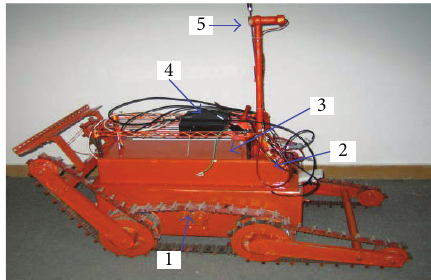
Figure 4: Coal mine rescue robot walking on the roadway.